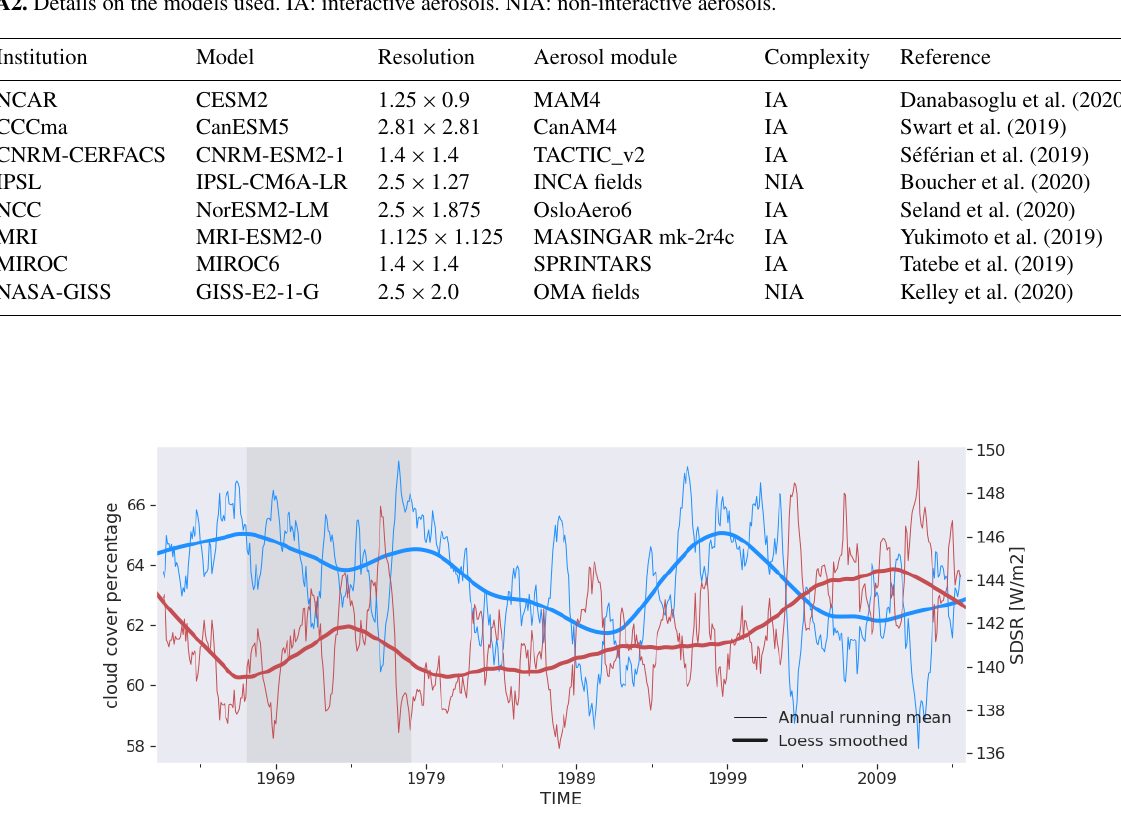
Figure A1. Time series of cloud cover (blue) and SDSR (red) between 1961 and 2014, co-located at GEBA sites in Europe. Thin lines show annual running means; bold lines show LOESS-smoothed variants. The shaded area delineates a period of interrupted dimming in Europe, between 1967 and 1978, which occurred simultaneously with a local minimum in the cloud cover trend.